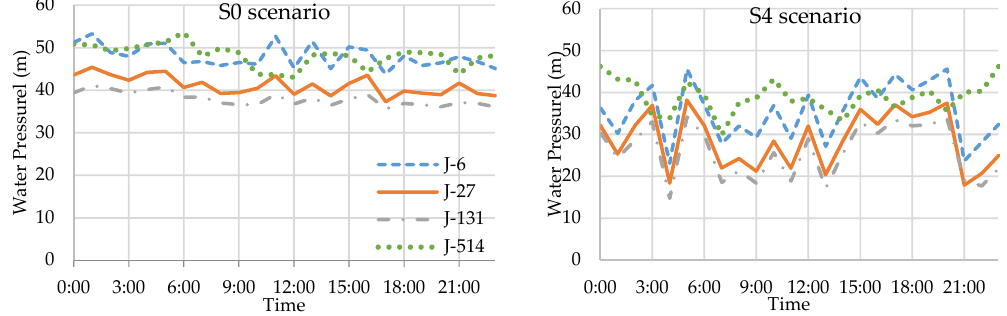
Figure 4. Typical water pressure pattern at junctions of S0 (left) and S4 (right) scenarios of the Monroe WDS.